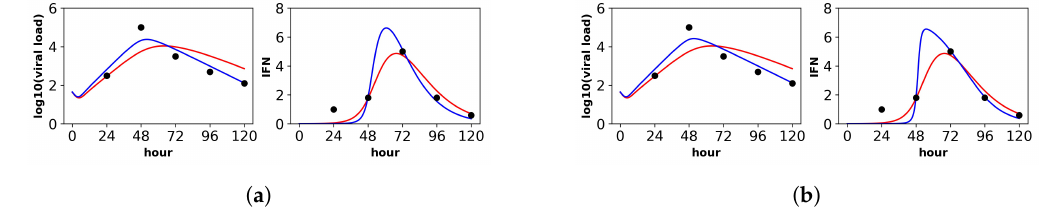
Figure 3. Fit of the extended model to Saenz et al.’s dataset. Shown is the fit of our extended model (blue), assuming a ( a ) constant secretion rate and a ( b ) pulsed secretion rate, and the fit of the Saenz et al. model (red). Our secretion rate models give comparable fits, but the pulsed model suggests faster increases in IFN